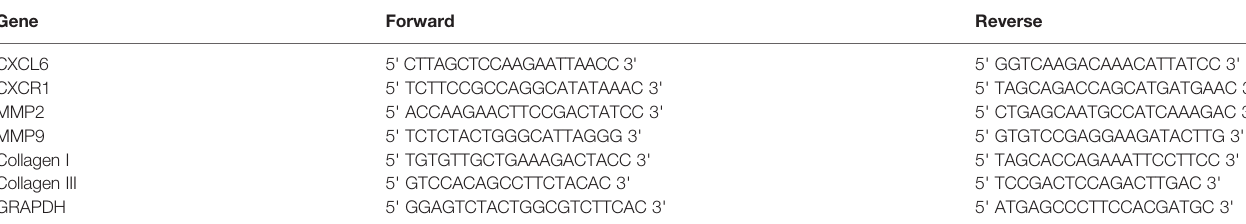
TABLE 2 | Gene primer pairs used for qRT-PCR.